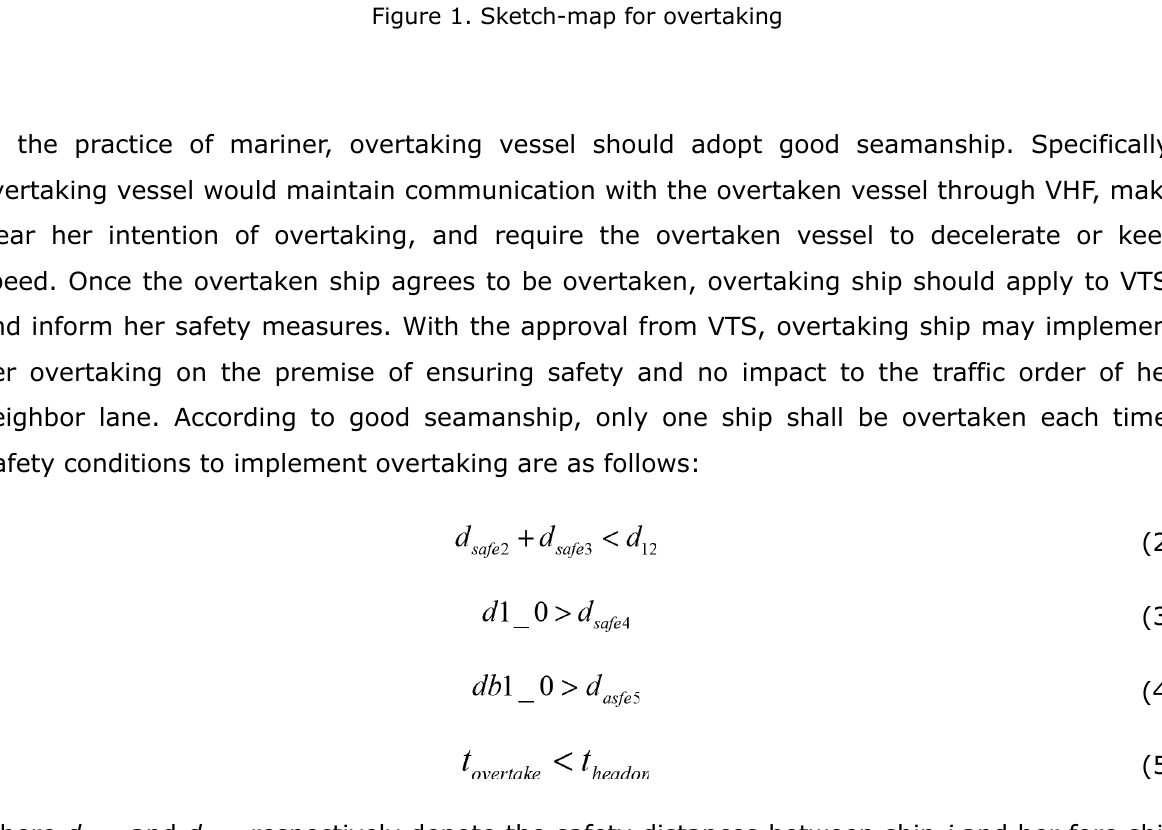
Figure 1. Sketch-map for